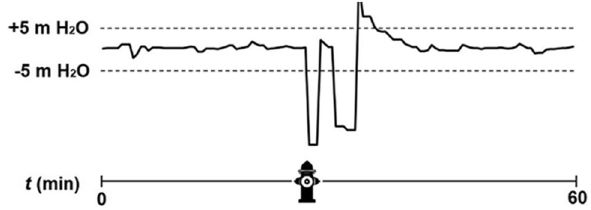
Fig. 9 Graph of the recorded pressure value changes during the test hydrant opening